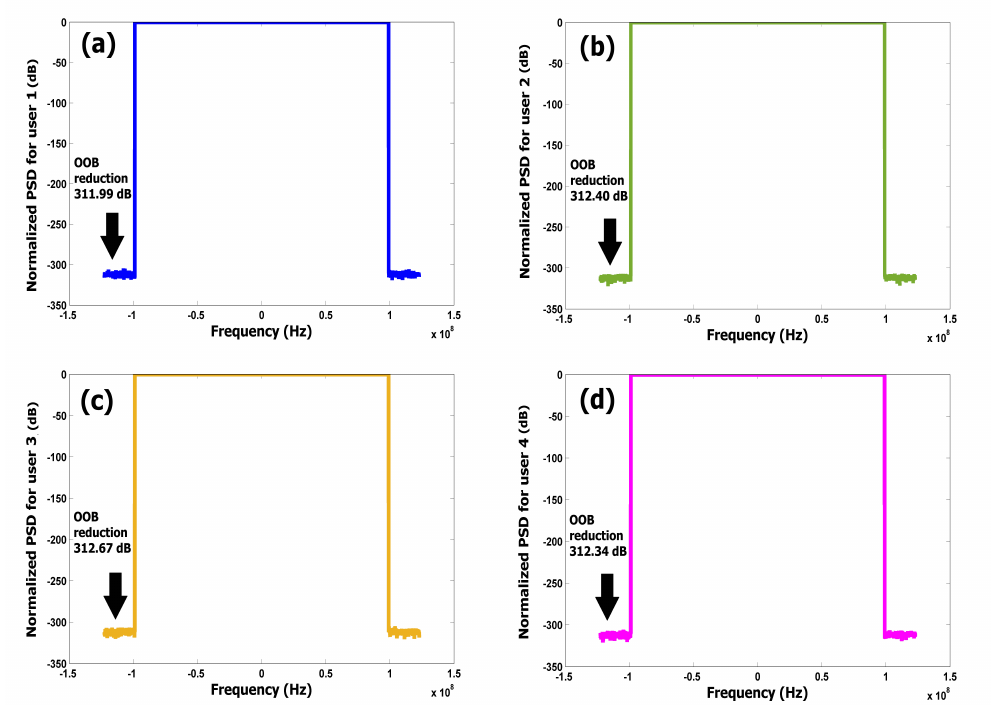
Figure 17. Power spectral density of the considered system with the implementation of 16 − QAM higher − order digital modulation, RA channel coding, and CHT schemes for the cases of ( a ) user 1, ( b ) user 2, ( c ) user 3, and ( d ) user 4.